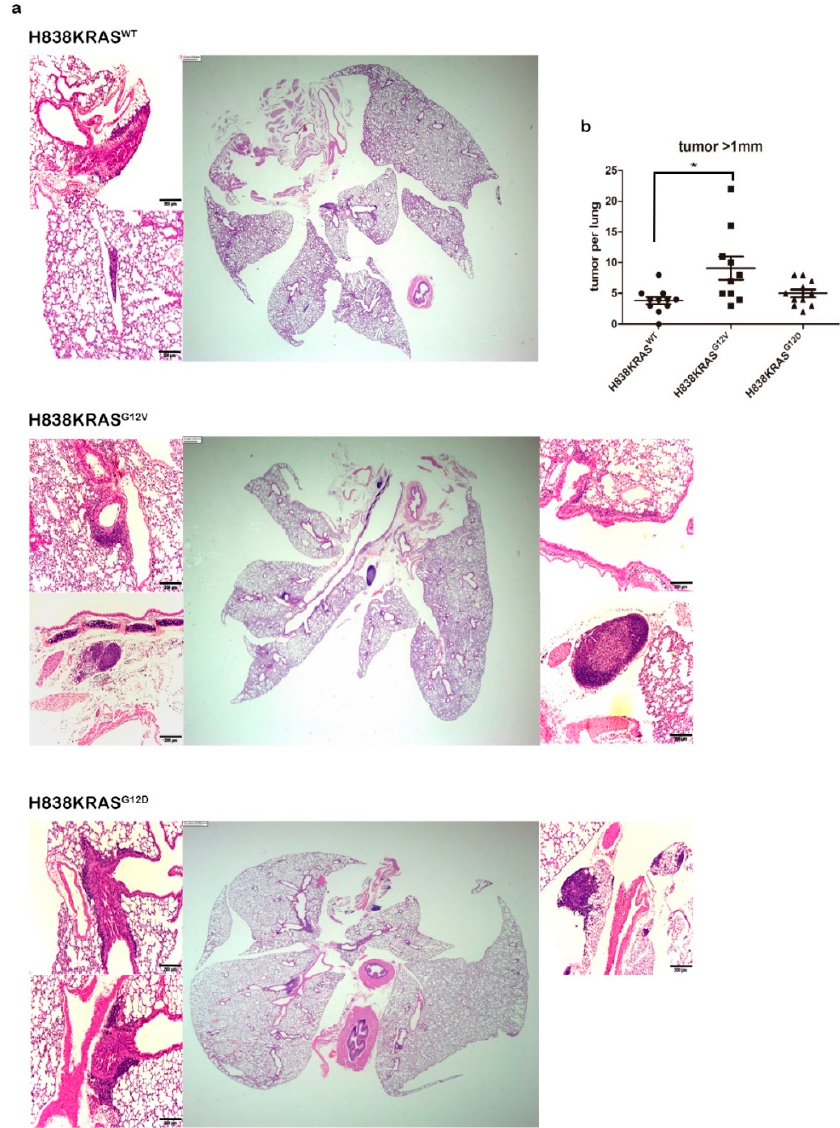
Figure 3. KRAS G12V mutation induced a greater amount of metastatic nodules in mice lung tissues. ( a ) Lung sections of mice stained with H&E. ( b ) The 10 lung sections from each mouse were examined. The average number of metastatic nodules in the 10 sections was acquired. The histograph showing the Mann–Whitney U statistical result of the group of KRAS WT ( n = 11), the group of KRAS G12V ( n = 10)